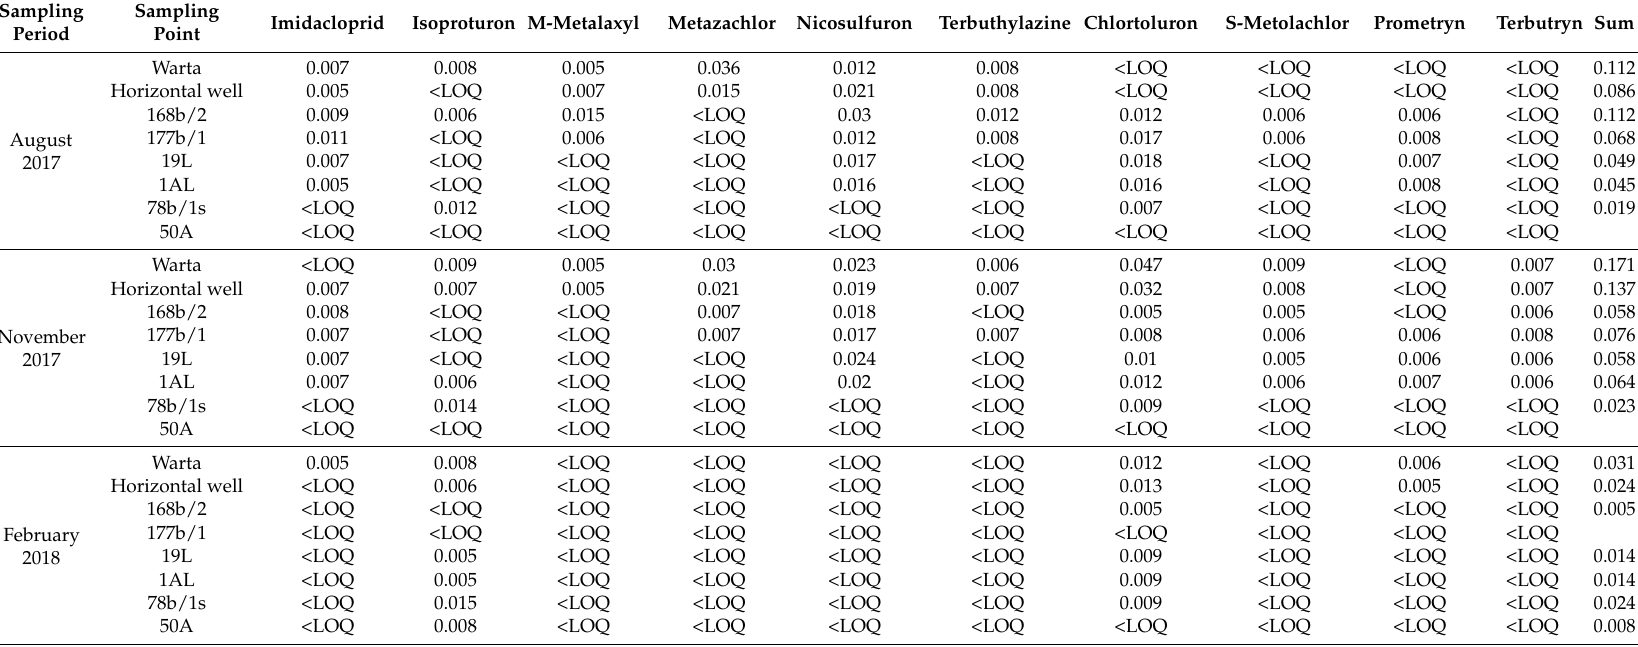
Table 3. Concentration of pesticides in µ g/L (LOQ <